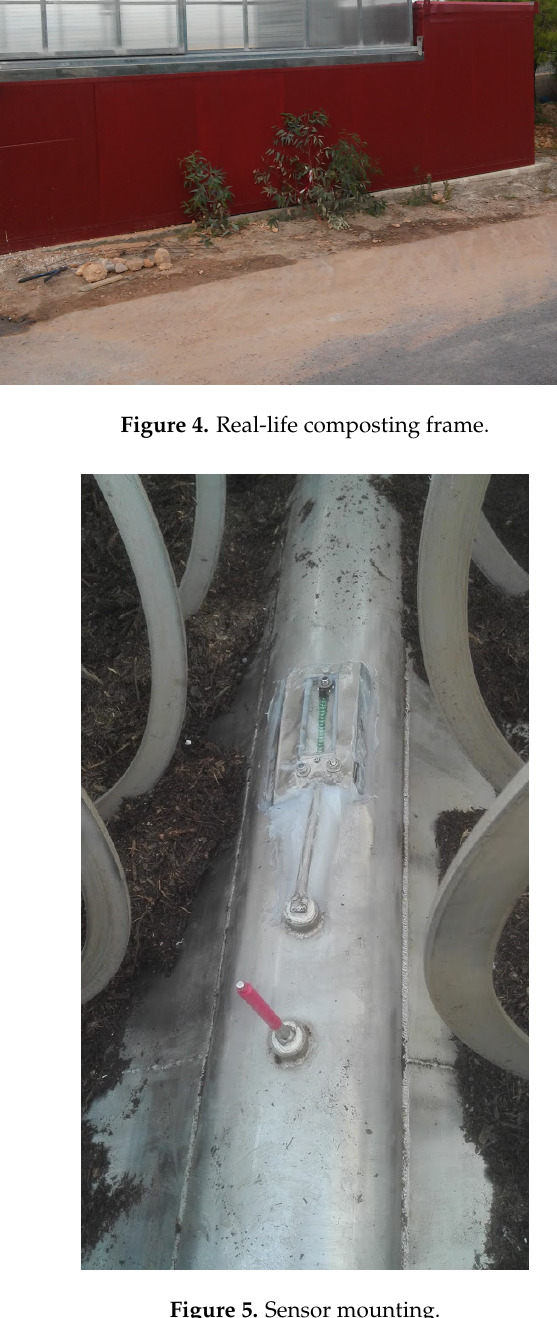
Figure 5. Sensor